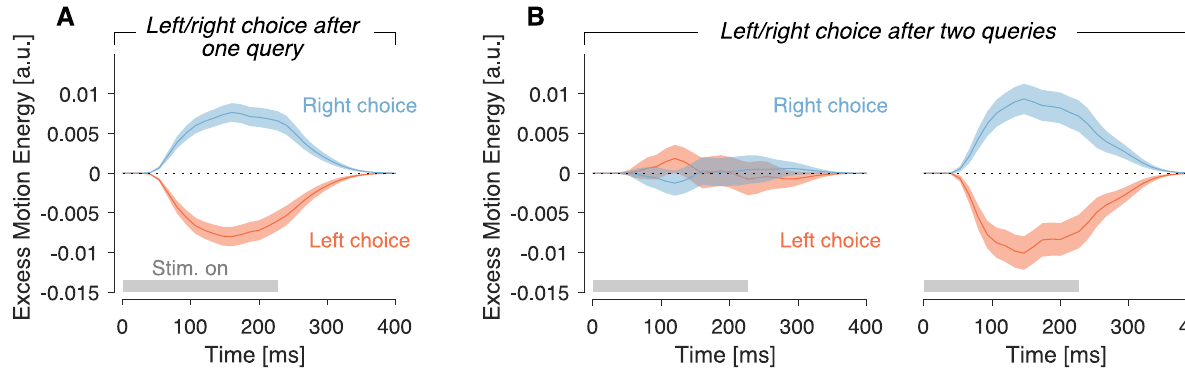
Fig 5. Only motion information from the last query informs the left/right choice. (A) Influence of motion energy residuals on the decision to descend levels through the left or right branch. The residuals were calculated by applying a filter to the sequence of random dots and subtracting the mean of all stimuli of the same motion strength and direction. Positive (negative) residuals indicate an excess of motion in rightward (leftward) direction. For left/right choices made after a single query, the motion energy residuals were positive for rightward choices and negative for leftward choices. (B) As panel A, except that we analyze the left/right choices made after two successive queries of the same internal node. The two panels show the motion energy residuals obtained from the first and second queries, sorted by the left/right choice made after the second one. Only the motion energy residuals from the second presentation distinguished between leftward and rightward choices, which indicates that the motion information from the first query did not influence the ultimate choice. Shading indicates s.e.m. The latency introduced by the impulse response of the motion energy filters explain the offset between the time of stimulus presentation (gray horizontal bars) and the onset of motion selectivity (Methods).